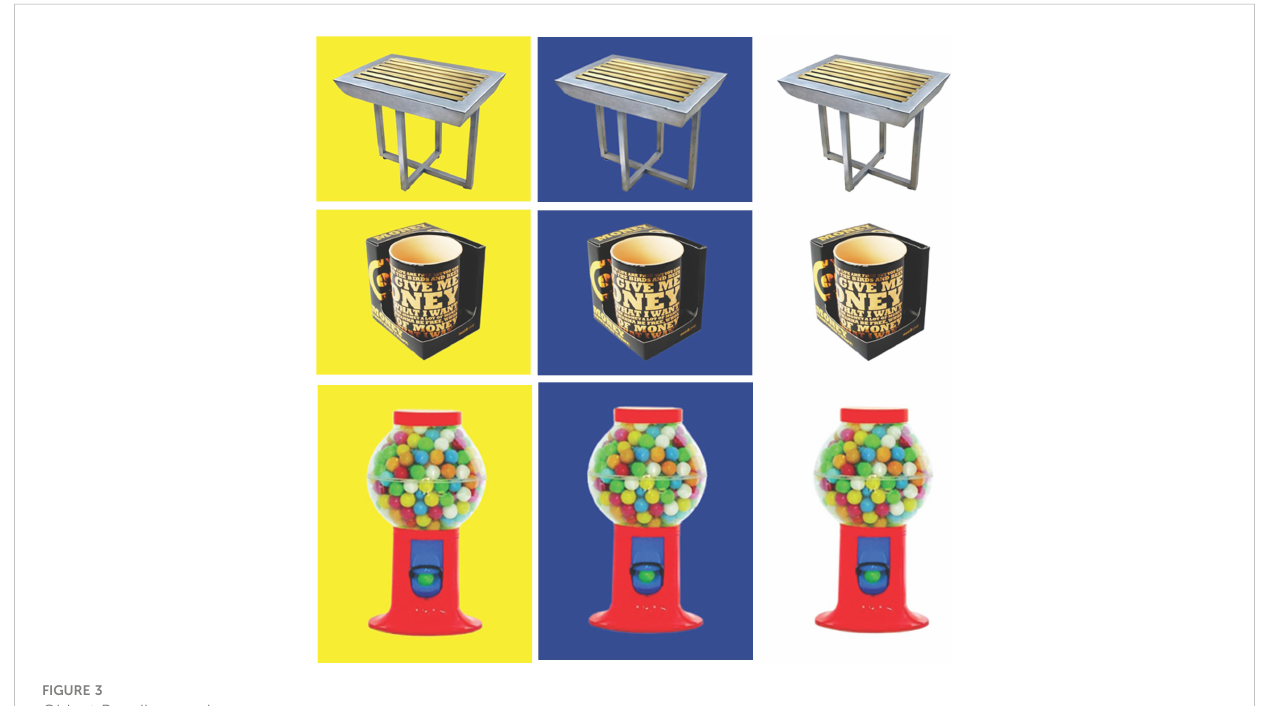
FIGURE 3 Object Recall examples.